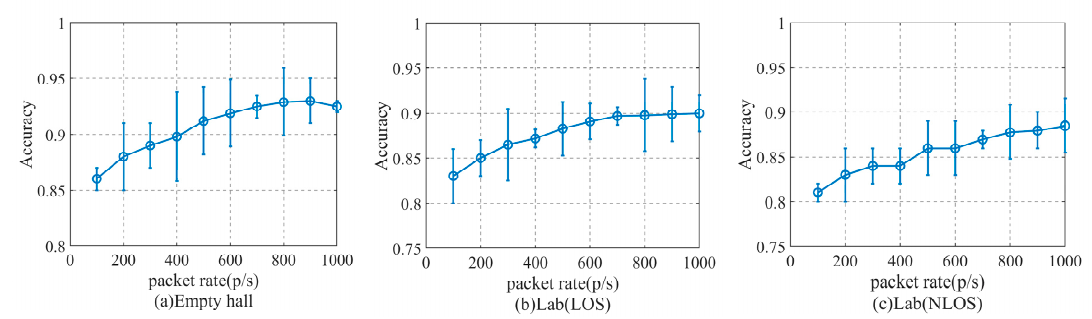
Figure 10. The impact of di ff erent packet delivery rates on the accuracy of the method. ( a ) Empty hall, ( b ) Lab (LOS), ( c ) Lab (NLOS).